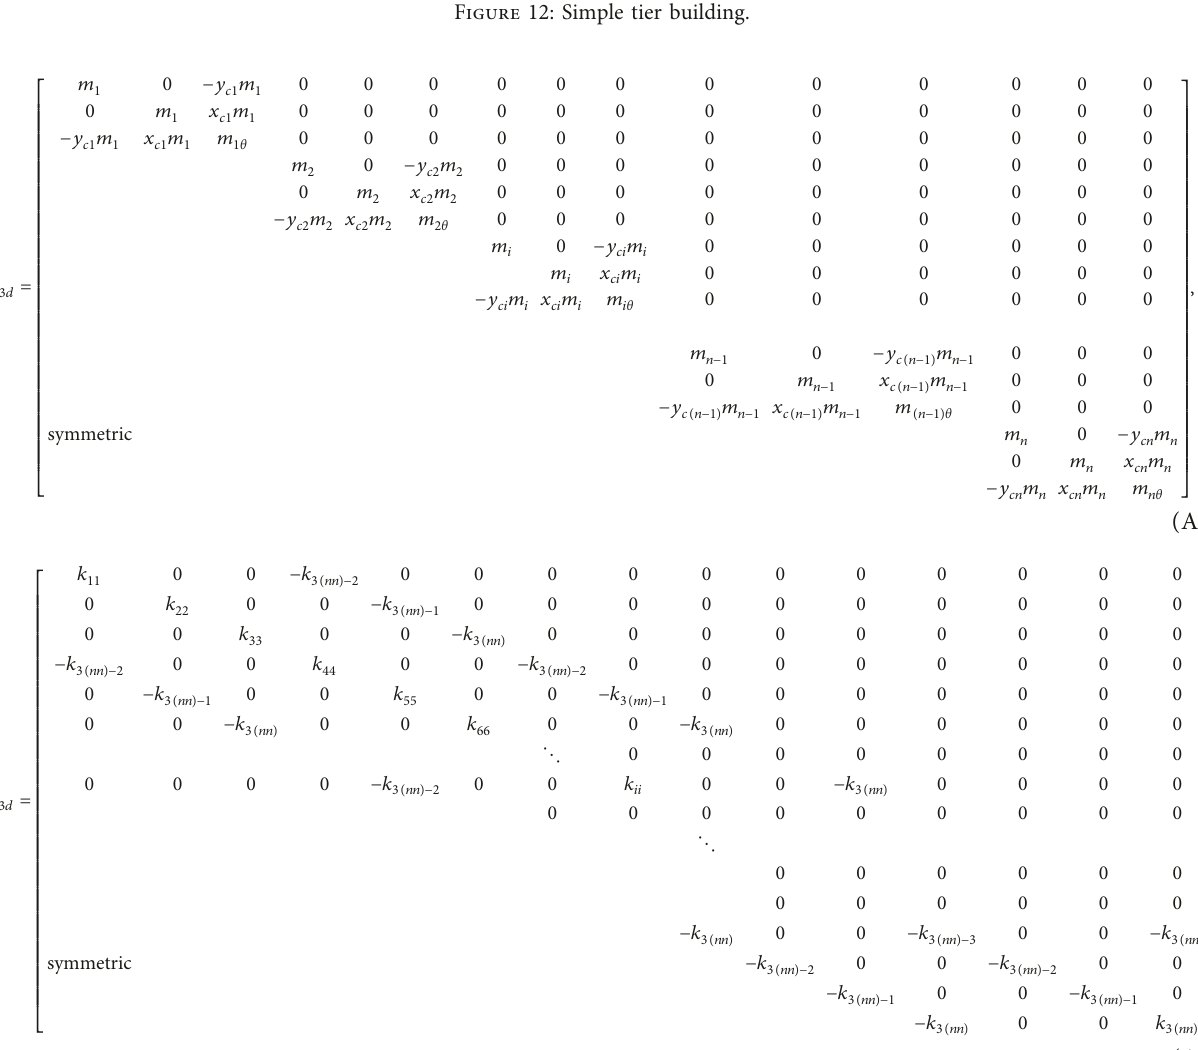
Figure 12: Simple tier